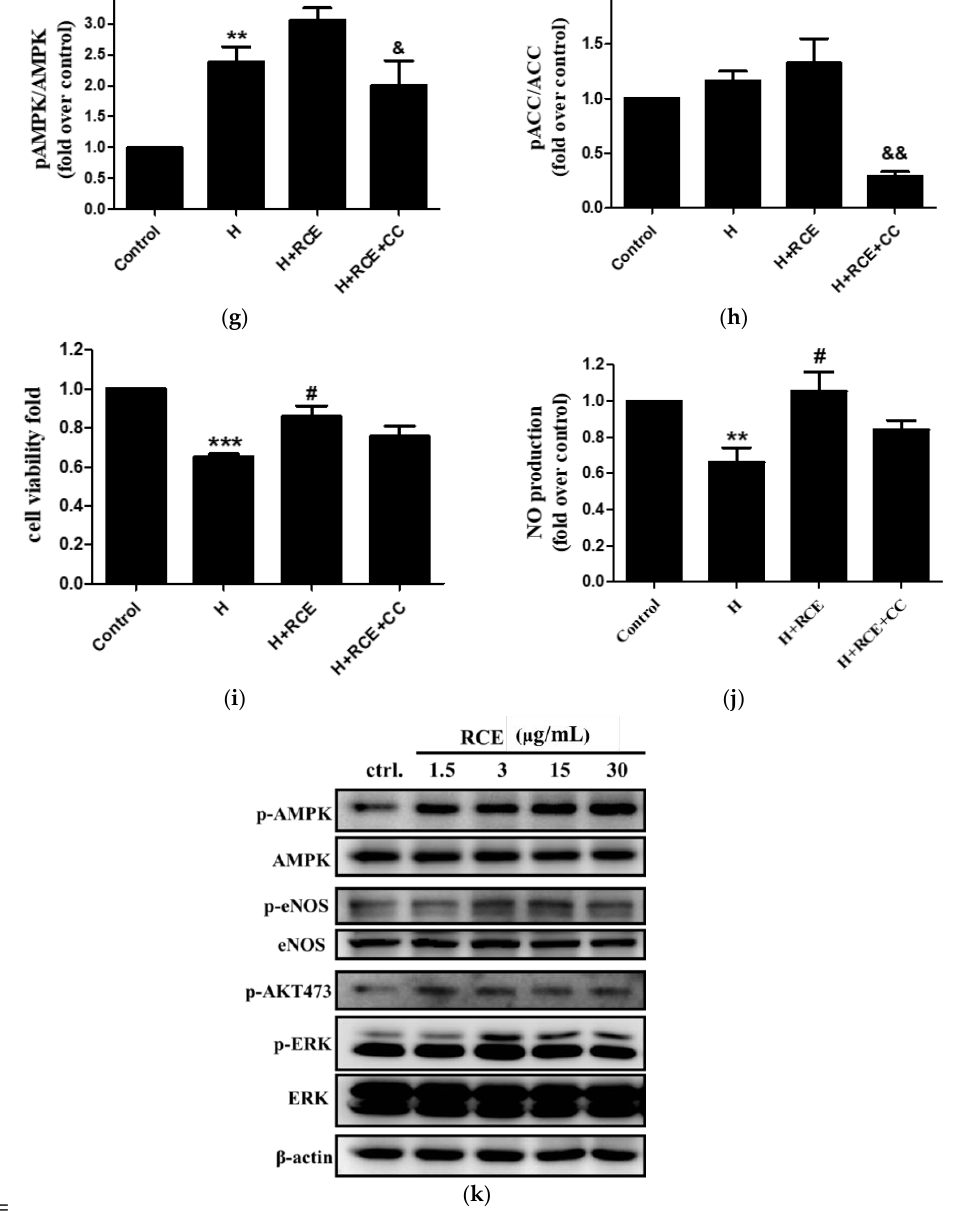
= Figure 4. Effect of Rhodiola crenulata root extract on the AMP-activated kinase-AKT-endothelial nitric oxide synthase (AMPK-AKT-eNOS) axis in HUVECs under hypoxic conditions. Phosphorylation of AMPK (Thr172), eNOS (Ser1177), and AKT (Thr308 and Thr473) was analyzed by Western blotting ( a ). Quantitative analysis of the relative levels of p-AMPK ( b ), p-eNOS ( c ), p-AKT (Thr308; ( d )), and p-AKT (Thr473; ( e )) was conducted. The cells were further treated with AMPK inhibitor (CC; compound C; 2 μM) for 30 min before RCE treatment (3 μg/mL) and hypoxia exposure (1% O 2 ) for 24 h. The effects of CC on p-AMPK and p-ACC were analyzed by Western blotting ( f ) and quantified ((p-AMPK; ( g )) and (p-acetyl-coenzyme A carboxylase (ACC); ( h )). β-actin served as a loading control. Cell viability was measured by using a CCK-8 kit ( i ), and the supernatant was collected for Griess assay ( j ). The cells were treated with RCE under normoxia ( k ). Results represent the mean ± SEM ( n = 6). * p < 0.05; ** p < 0.01; *** p < 0.001 versus control; # p < 0.05 versus hypoxia; & p < 0.05 and && p < 0.01 versus hypoxic condition with RCE.